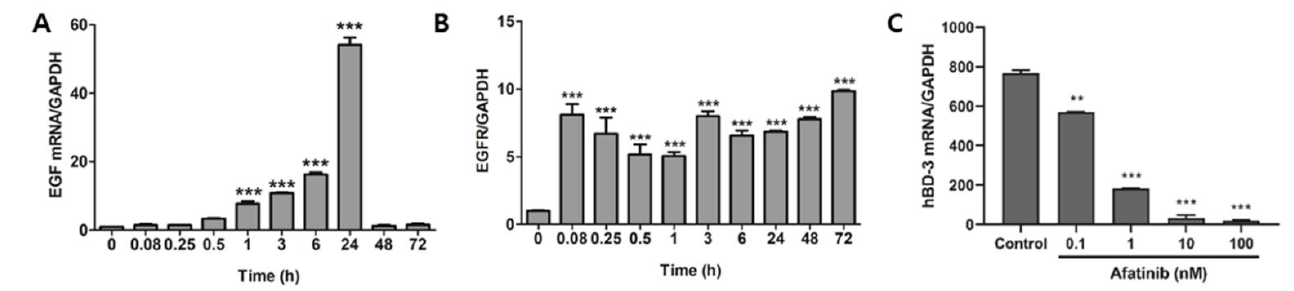
Figure 4. EGFR is involved in KG lysate-mediated hBD3 induction. HaCaT cells were treated with 1 × 10 9 cells/mL KG lysates for the indicated times and EGF mRNA ( A ) and EGFR mRNA ( B ) was examined by real-time PCR. ( C ) HaCaT cells were pretreated with afatinib and re-treated with KG lysates. hBD3 mRNA level was examined by real-time PCR. **p<0.01 and ***p<0.001.